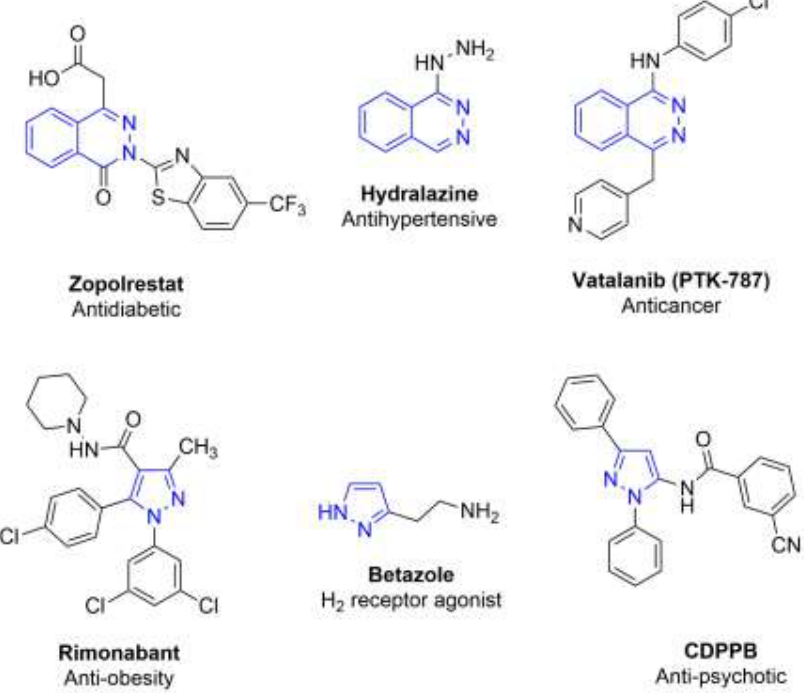
Figure 1. Commercially available drugs with phthalazine or pyrazolo